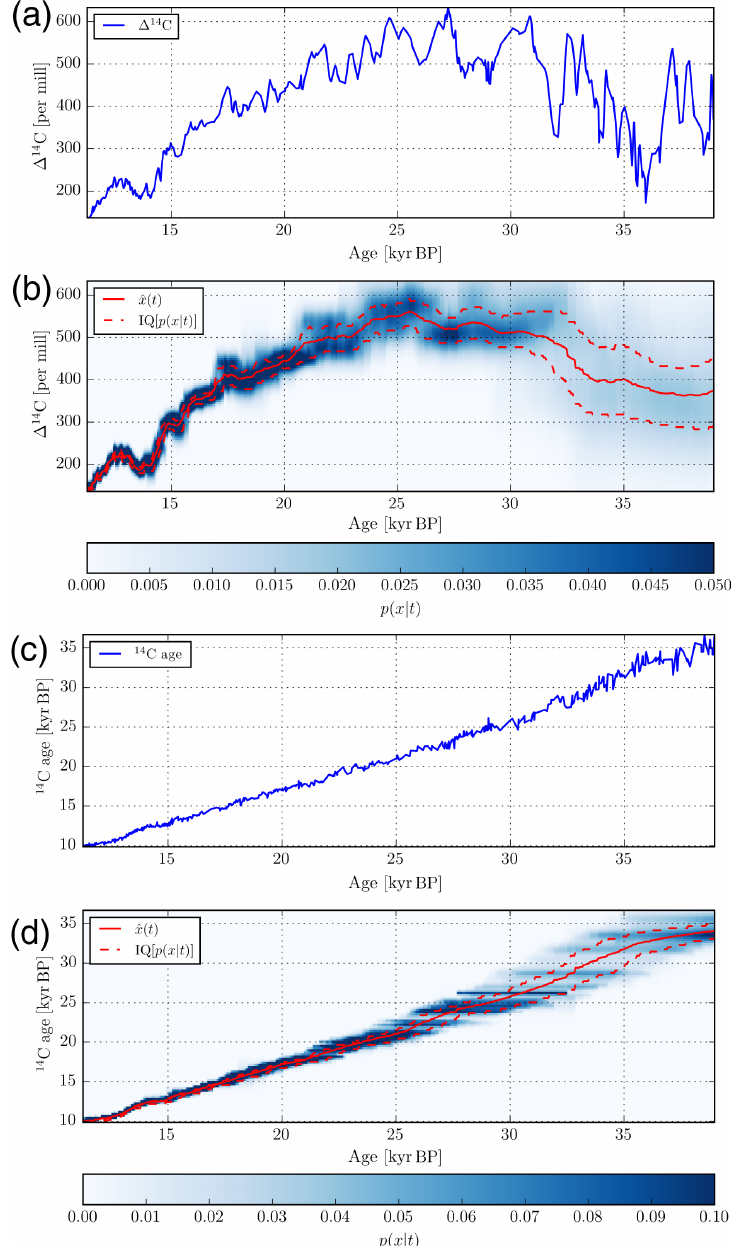
Figure 5. Representation of the Suigetsu lake sediment data, taking into account proxy uncertainties as well as absolute counting errors in the dating. (a) Traditional representation of the (cid:49) 14 C time series, without accounting for uncertainties. The time span corresponds to the interval for which a varve-counted chronology is available. (b) Representation of the (cid:49) 14 C from the Suigetsu lake sediment dataset as a sequence of probability densities, derived via Eq. (4). As for the NGRIP record (Fig. 3), a uniform distribution of width 2 · MCE is used for the age uncertainty distribution p ( t | z ). (c) The radiocarbon ( 14 C) comparison curve derived from the Suigetsu record, without accounting for uncertainties. (d) Representation of the Suigetsu radiocarbon comparison curve as sequence of probability densities, taking into account radiocarbon measurement errors as well as errors originating from varve